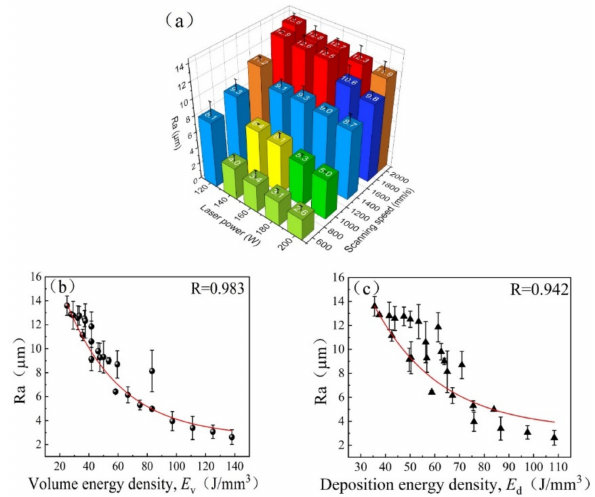
Figure 3. ( a ) Histogram of the top surface roughness at different laser powers and scanning speeds, showing changes in the top surface roughness as a function of ( b ) volume energy density and ( c ) deposition energy density.